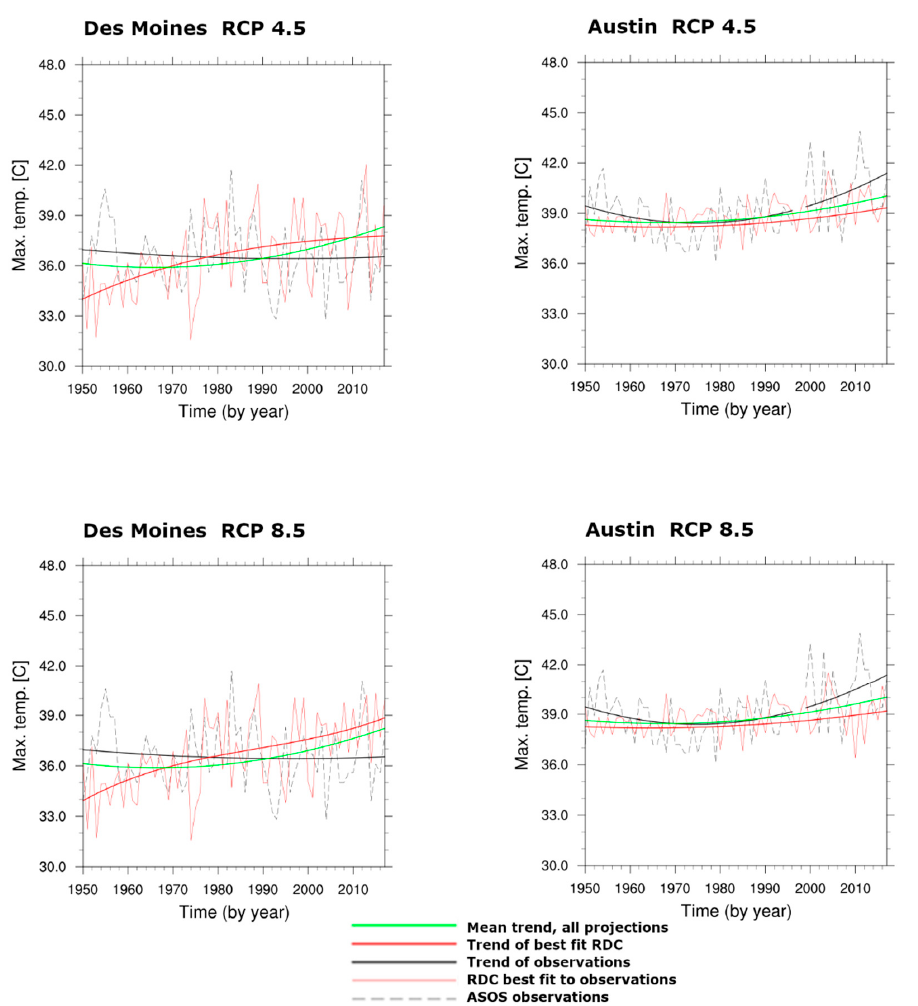
Figure 3. Trend of annual maximum temperatures (black solid line) for Des Moines ( left ) and Austin ( right ) based on 67-years (1950–2017) historical observations compared to RDC data for RCP 4.5 ( top ) and RCP 8.5 ( bottom ) climate scenarios. Data and trends are identified by color and line type as given in the legend.